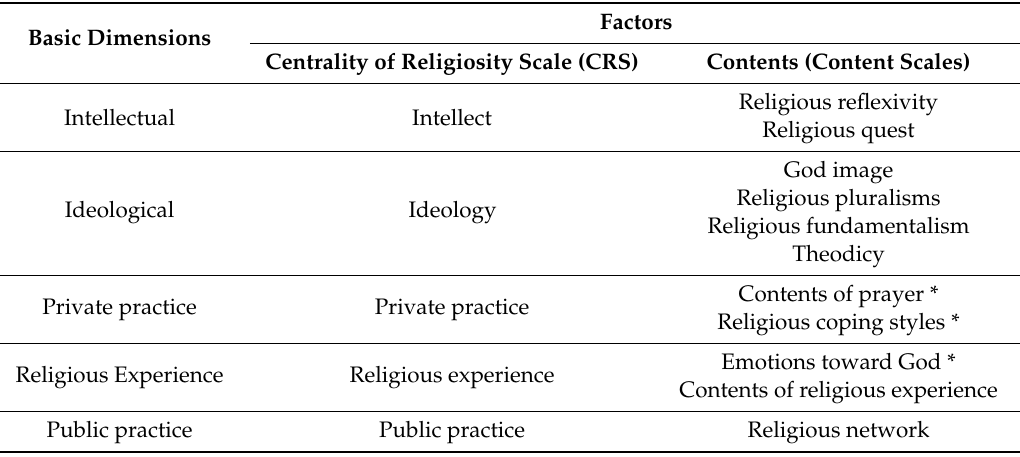
Table 1. The Religious Structure Test